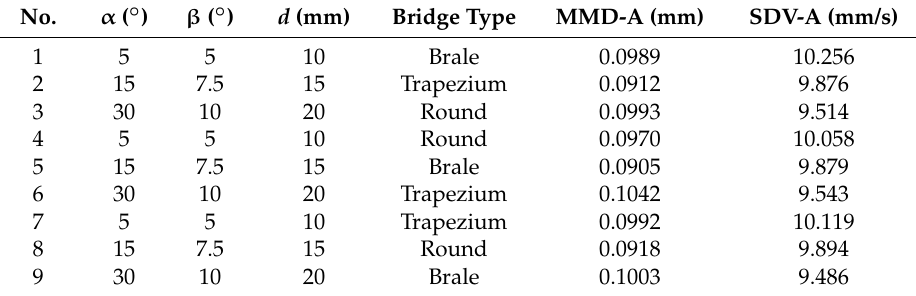
Table 5. The parameter conditions based on the L9 orthogonal array of the Taguchi